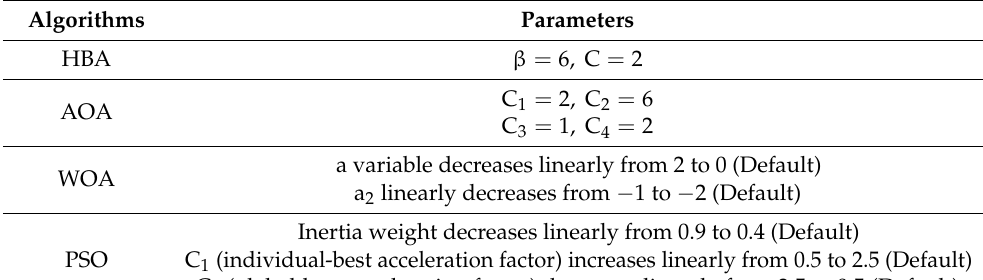
Table 2. Parameters related to metaheuristic algorithm.